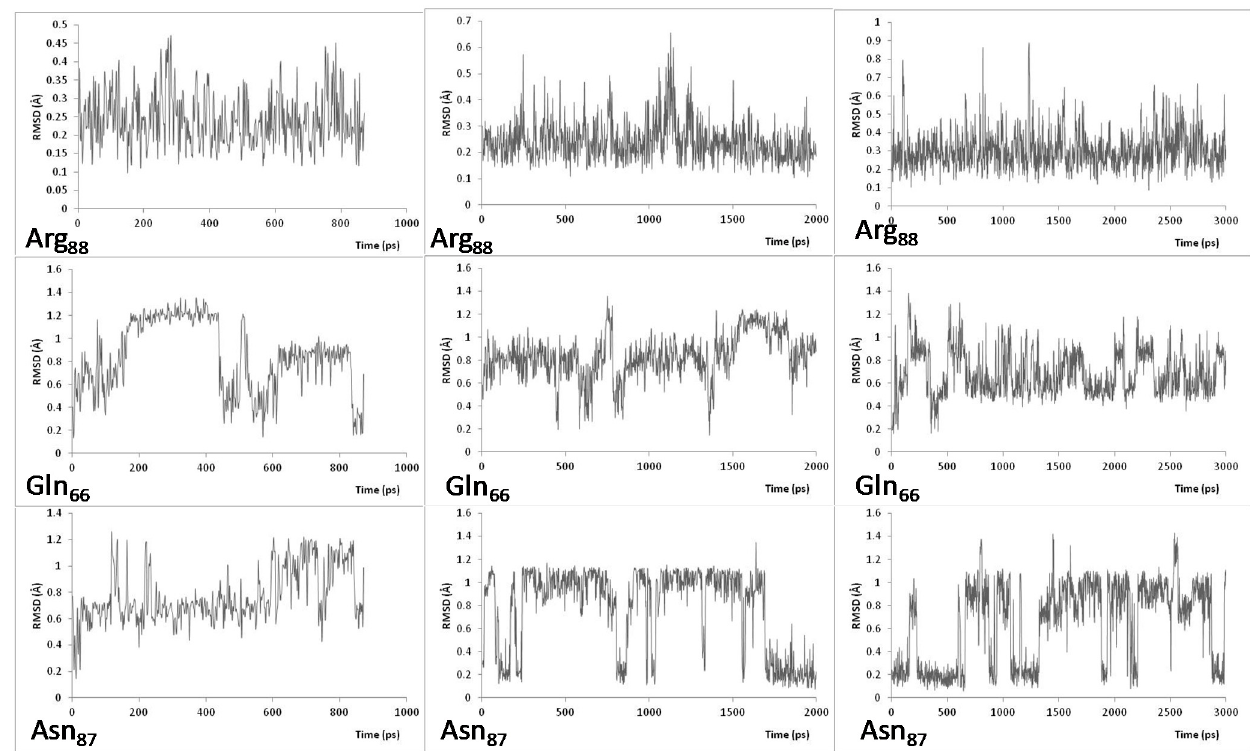
Figure 2. Plots of Root Mean Square Deviation (RMSD) of Arg88, Gln66, and Asn87 over the course of 1, 3, and 6 ns MD simulations, at 333 K, of the P450-TT enzyme.